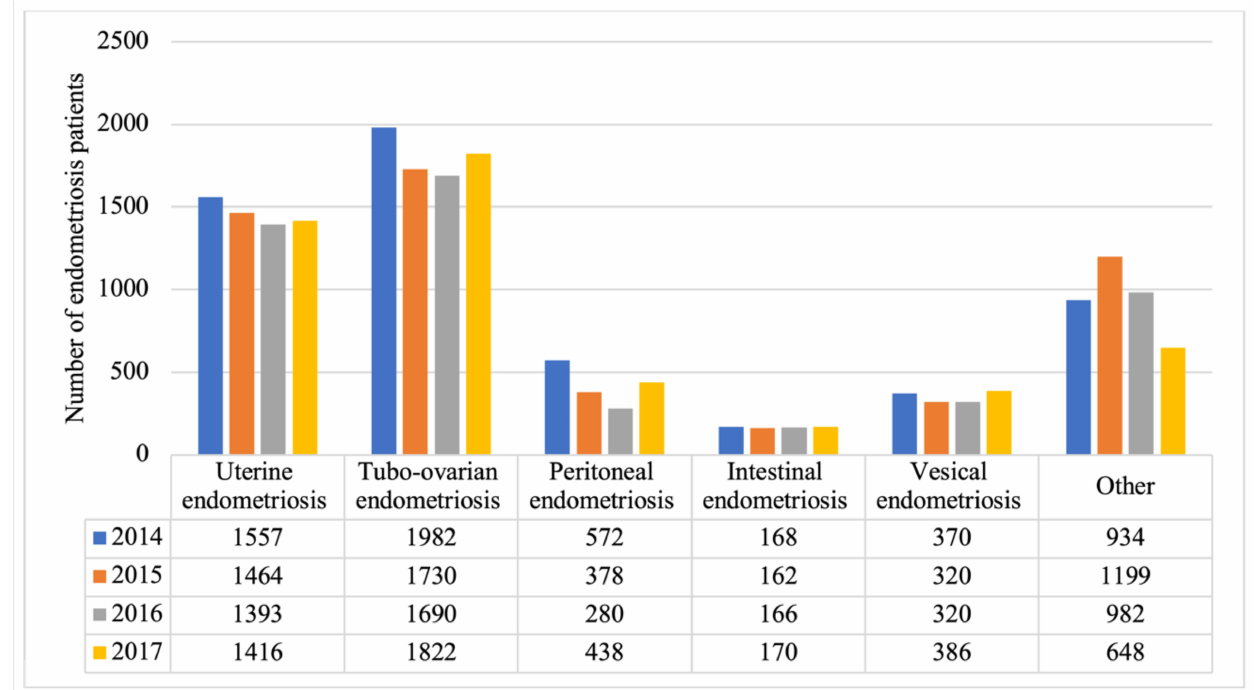
Figure 1. Number of endometriosis patients according to type of endometriosis